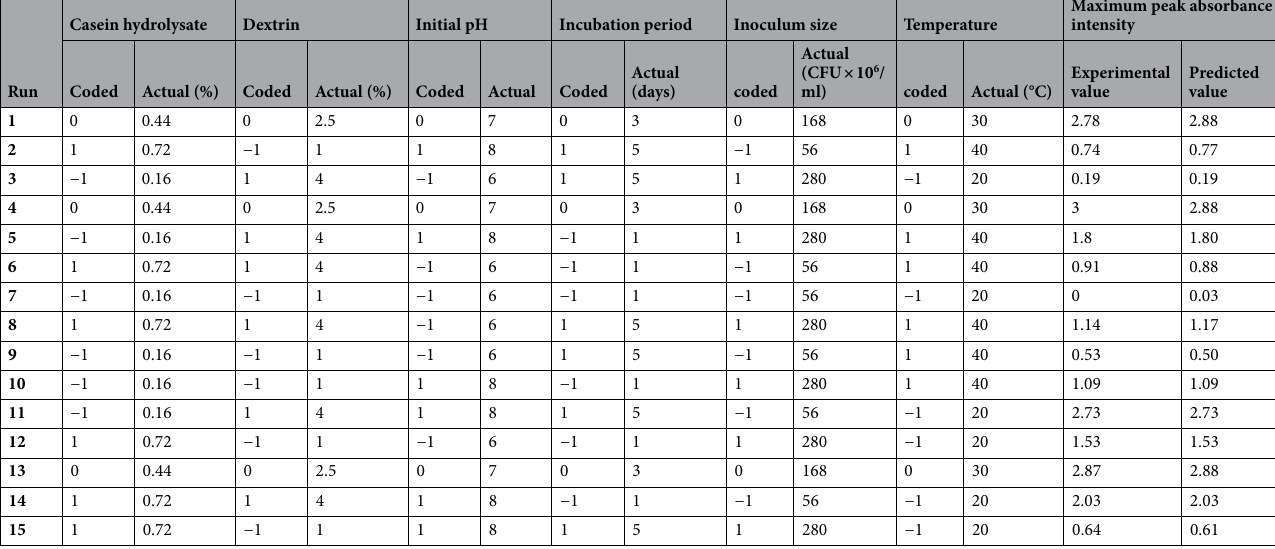
Table 2. PBD layout for AuNPs biosynthesis, using Bacillus subtilis NRC1 extracellular filtrate.